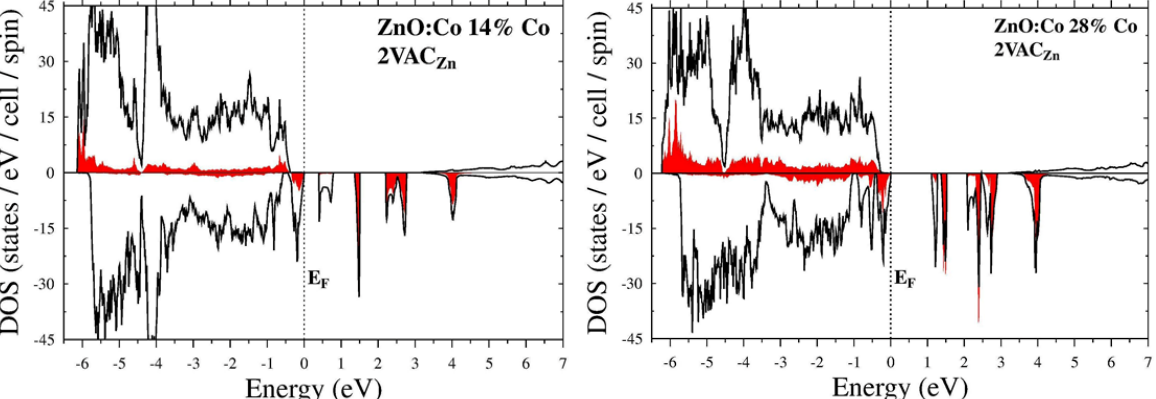
Fig. 2. Relativistic MBJ DOS with two Zn vacancies in Zn 1-x Co x O for x=0.14 (left panel) and for x=0.28 (right panel). Bold line – total DOS, shaded red region – 3d Co partial DOS, E F means the Fermi